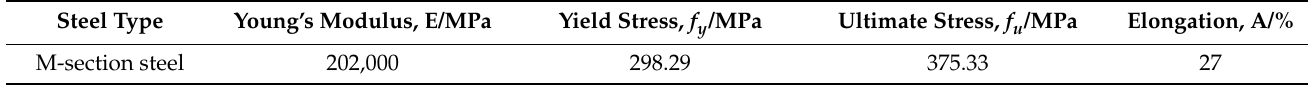
Table 3. Material properties of the